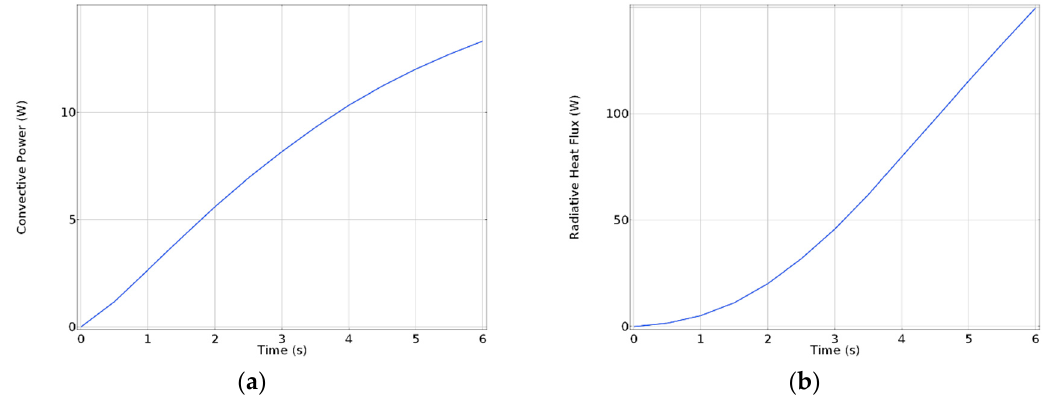
Figure 10. Power loss—brazing assembly (copper), ( a ) convection, ( b ) radiative.